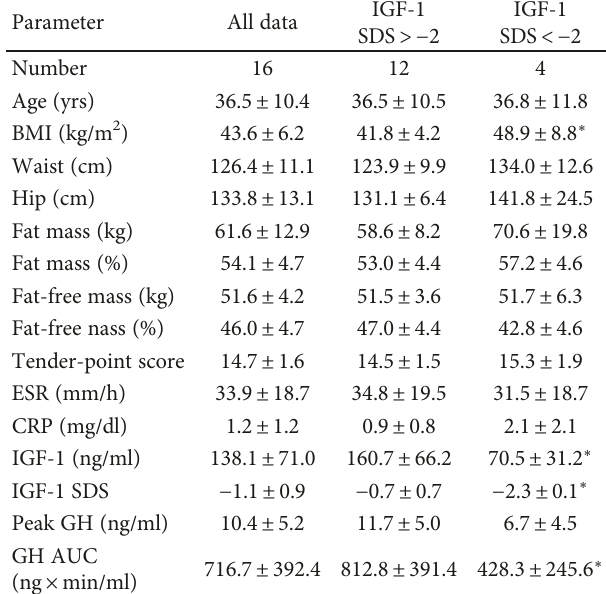
Table 1: Demographic, clinical, and hormonal characteristics of the obese women with fi bromyalgia syndrome included in the